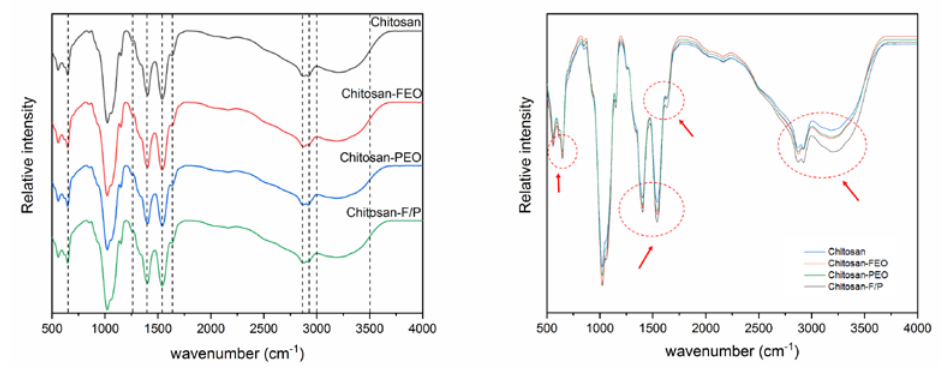
Figure 1. FTIR spectra of Chitosan, Chitosan-FEO, Chitosan-PEO, and Chitosan-F/P